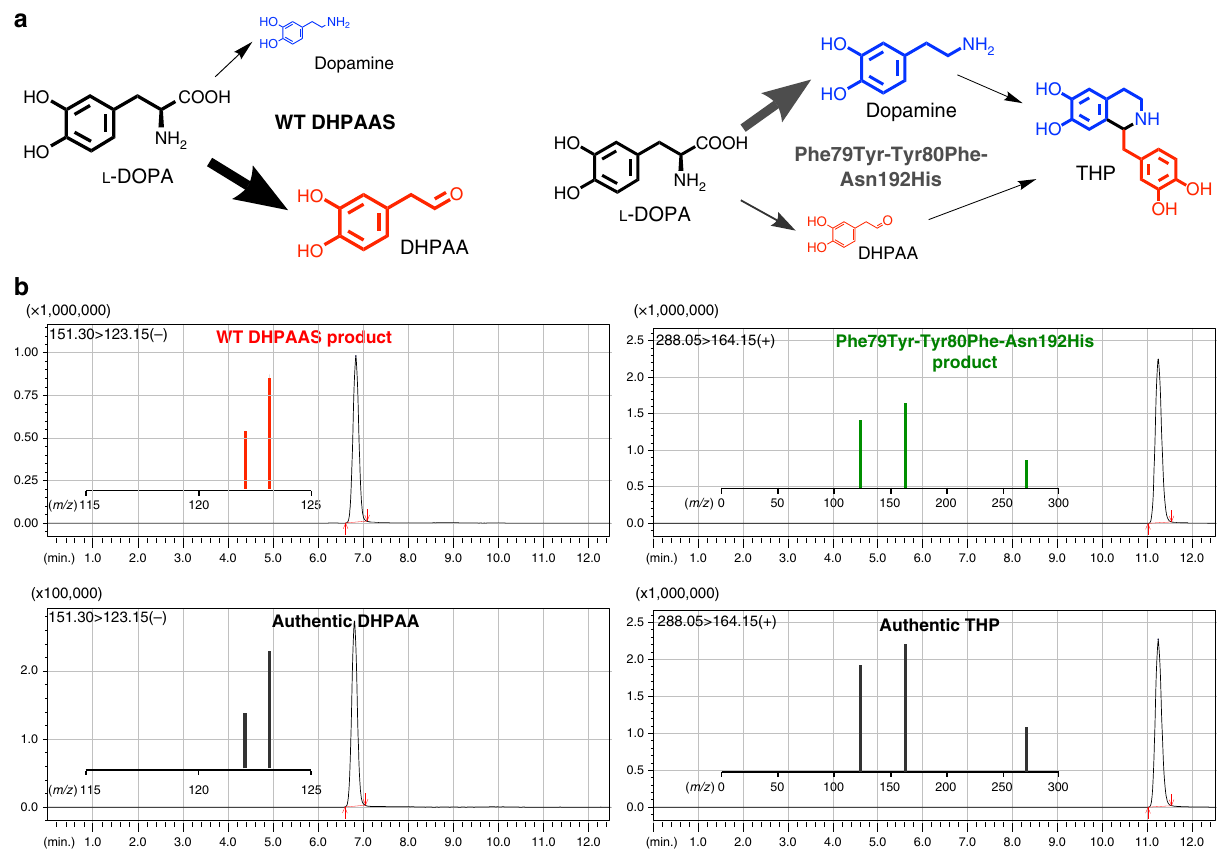
In contrast to the in vitro results, the Phe79Tyr-Tyr80Phe variant was the best relative in vivo THP producer of this study, with titers exceeding 1 µM (0.287 mg/L). Wild-type DHPAAS produced the next highest amounts of in vivo THP, followed by Phe79Tyr-Tyr80Phe-Asn192His DHPAAS as the third-best THP producer. The Asn192His variant produced the lowest in vivo THP titers when including ascorbate. A diastereomeric mixure of ( R,S )-THP was produced by DHPAAS in vivo as demonstrated by chiral LC-MS analysis (Supplementary Figure 6). After addition of Coptis japonica 6-OMT , CNMT and 4-OMT genes (Fig. 1) to DHPAAS expressing E. coli , THP and reticuline production followed similar trends. The Asn192His and Phe79Tyr-Tyr80Phe-Asn192His DHPAAS variants resulted in Fig. 6 Kinetic analysis of DHPAAS H 2 O 2 producing activities. DHPAAS higher reticuline titers than THP titers suggesting high conver- produces DHPAA, CO 2 , H 2 O 2 , and NH 4 + from L -DOPA, O 2 , and H 2 O. sion of THP to reticuline. However, reticuline titers were limited Production of H 2 O 2 by wild-type DHPAAS and catalytic variants was to approximately 0.2 µM using all four DHPAAS variants, which monitored with a fl uorometric assay. The graph was generated and indicates that there is a bottleneck in the conversion of ( R , S )-THP analyzed with Prism 7 ( n ≥ 8 independent measurements). The to reticuline under the conditions tested (Fig. 7g, h). corresponding kinetic analysis is included in Table 1. Source data are To improve the limited reticuline titers, additional DHPAAS , provided in a Source Data fi le DDC , 6-OMT , and CNMT genes were tested. Addition of a bacterial DDC resulted in an increase in THP titers to above 2 µM (0.57 mg/L), accompanied by a huge increase in dopamine levels. However, reticuline titers did not simply increase dependent on THP concentration, with the bottleneck appearing strongest at the 6-OMT and 4-OMT steps. Expression of DHPAAS- Phe79Tyr-Tyr80Phe-Asn192His together with wild-type NATURE COMMUNICATIONS| (2019)